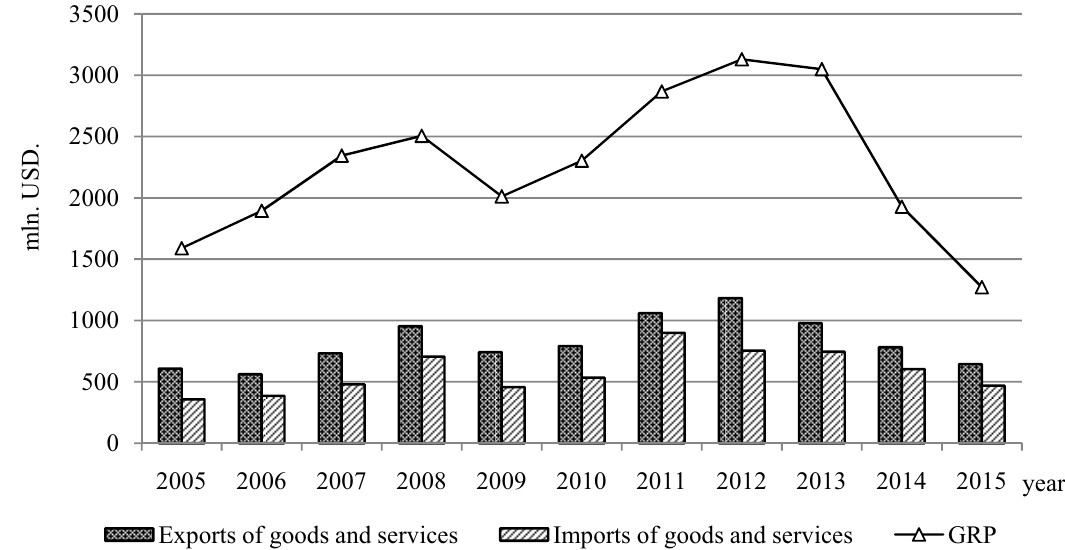
Fig. 2. Dynamics of export and import of goods and GRP in the Sumy region of Ukraine for 2005-2015 Source: Krenz, Astrid